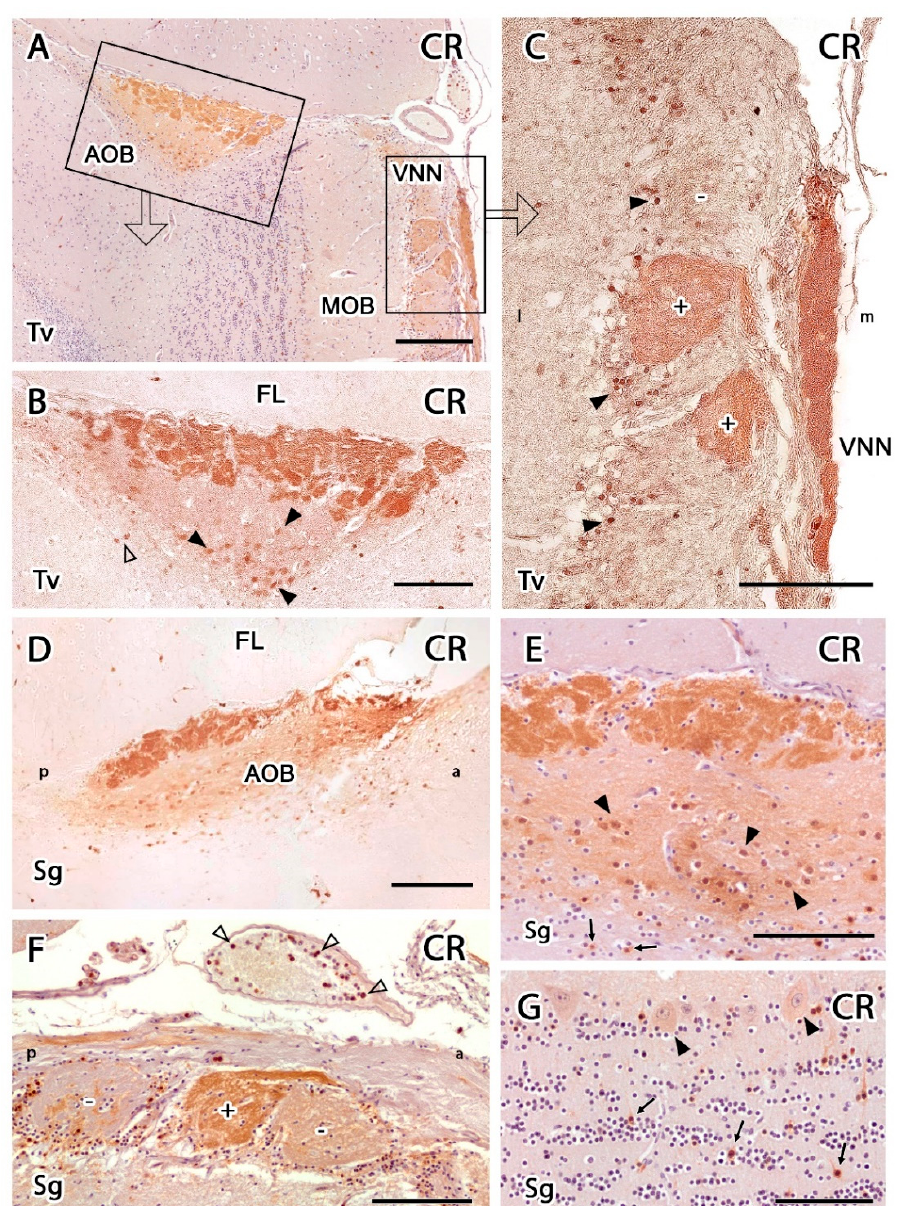
Figure 11. Anti-calretinin (CR) immunohistochemical study of the olfactory bulb in the meerkat. ( A ) Transverse section of the dorsomedial part of the olfactory bulb (OB) counterstained with hematoxylin. Strong immunopositivity can be seen in the accessory olfactory bulb (AOB), the vomeronasal nerve (VNN), and the glomeruli of the main olfactory bulb (MOB). ( B ) Enlargement of the left box in A, not counterstained. The immunolabelling of the AOB is concentrated in the nerve and glomerular layers and with less intensity in the mitral-plexiform and granular layers. Immunopositive mitral cells are identified in both the mitral-plexiform (black arrowhead) and granular layers (open arrowhead). ( C ) Enlargement of the area corresponding to the right box in A, but without counterstaining, showing the strong immunolabelling of the VNN and the presence in the dorsomedial part of the MOB of atypical CR-immunopositive glomeruli (+), in contrast to the typical CR-immunonegative glomeruli ( − ). A subpopulation of periglomerular cells were also immunopositive (arrowheads). ( D ) Sagittal section of the AOB confirming the positive immunolabelling pattern found in the transverse section. ( E ) Hematoxylin counterstained sagittal section of the AOB showing the density of immunopositive mitral cells in the mitral-plexiform layer (arrowheads) and isolated CR-positive granule cells in